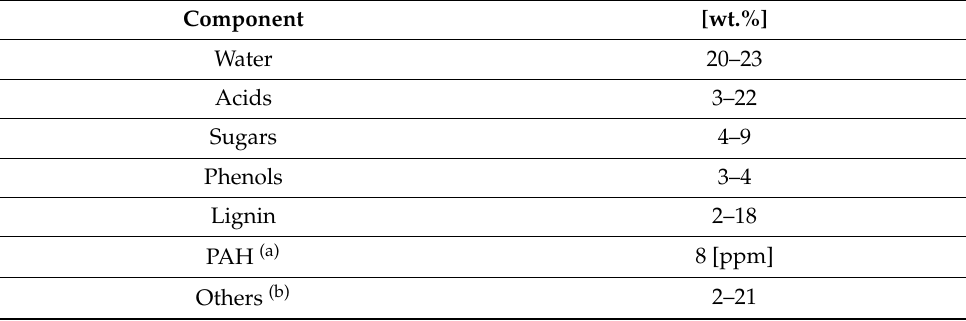
Table 5. Example of the composition of bio-oil